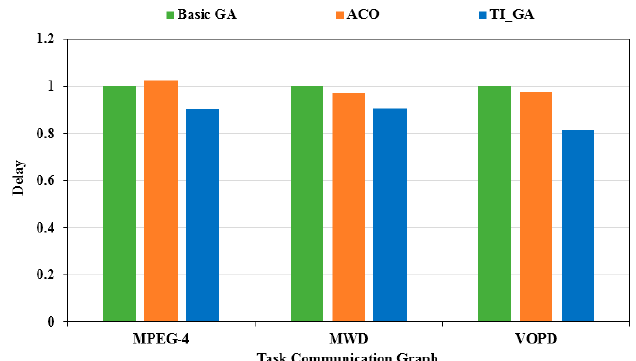
Figure 13. TI_GA, traditional genetic algorithm and ACO for MPEG-4, MWD, VOPD delay results comparison ( μ e : μ d = 1:2).